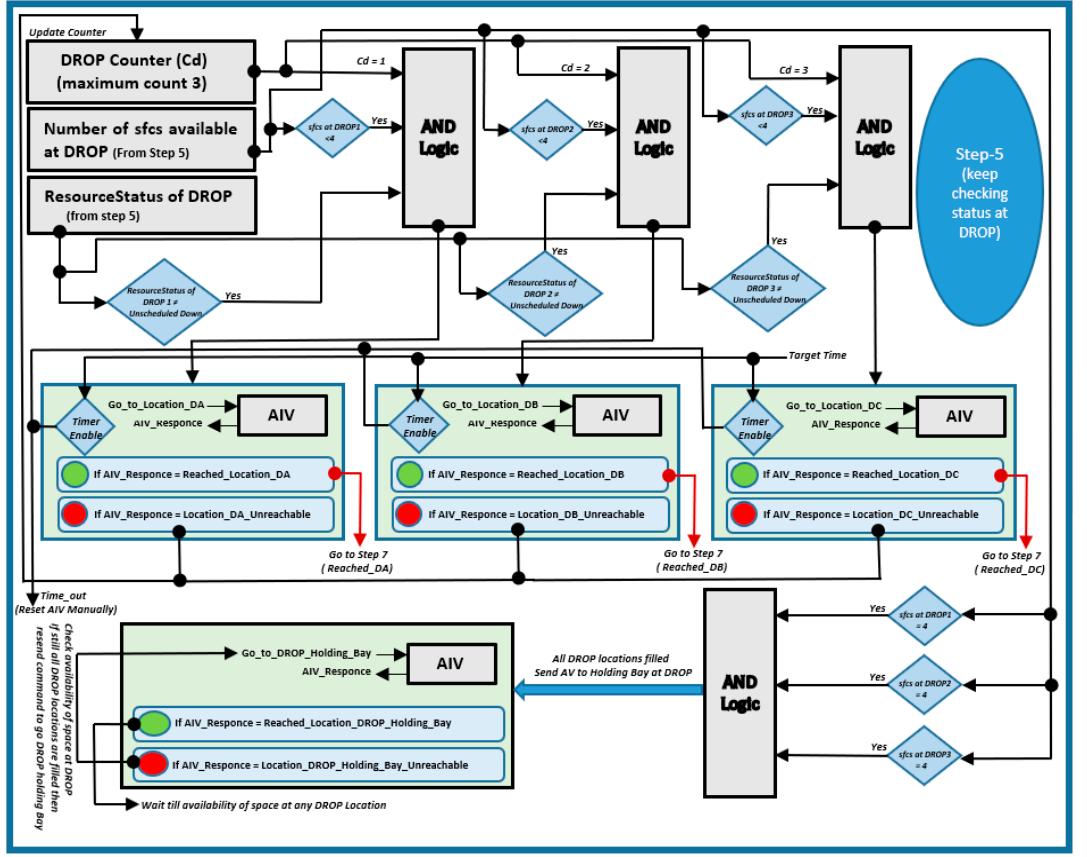
Figure 15. Check status of drop ‐ off locations.